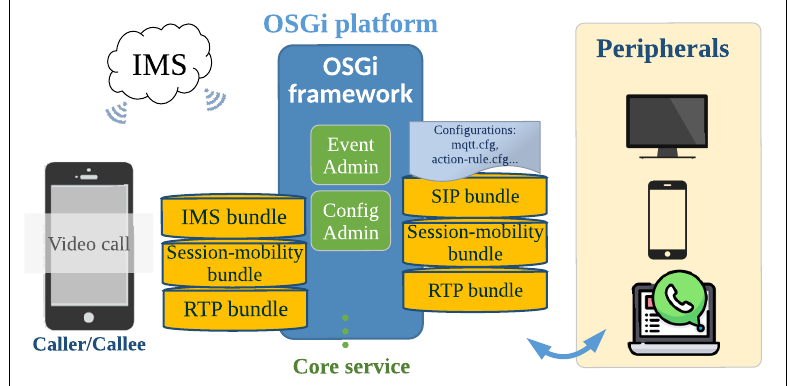
Figure 4. Architecture for operations between IMS and relative Bundles.